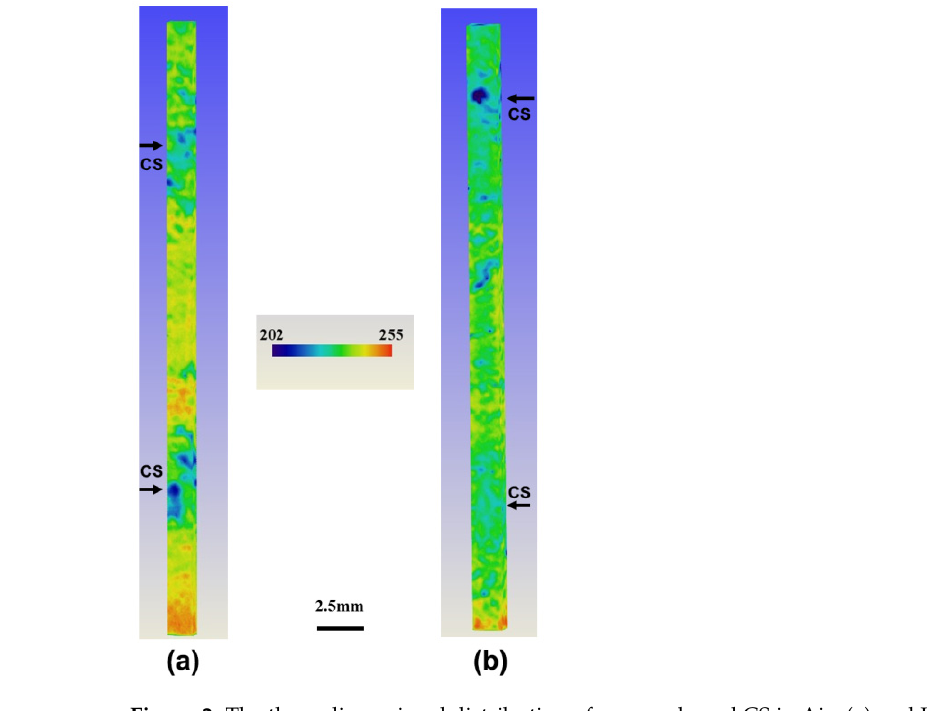
Figure 2. The three-dimensional distribution of grey scale and CS in Air- ( a ) and He-cooled ( b ) NbTi ingots by 3D microtomography. The sample of Φ 2 mm × 28 mm was obtained in the center of the test piece, and the reconstructed zone is 1.875 × 1.875 × 25 mm 3 . The observed two channels (blue color) are marked by the black arrows.